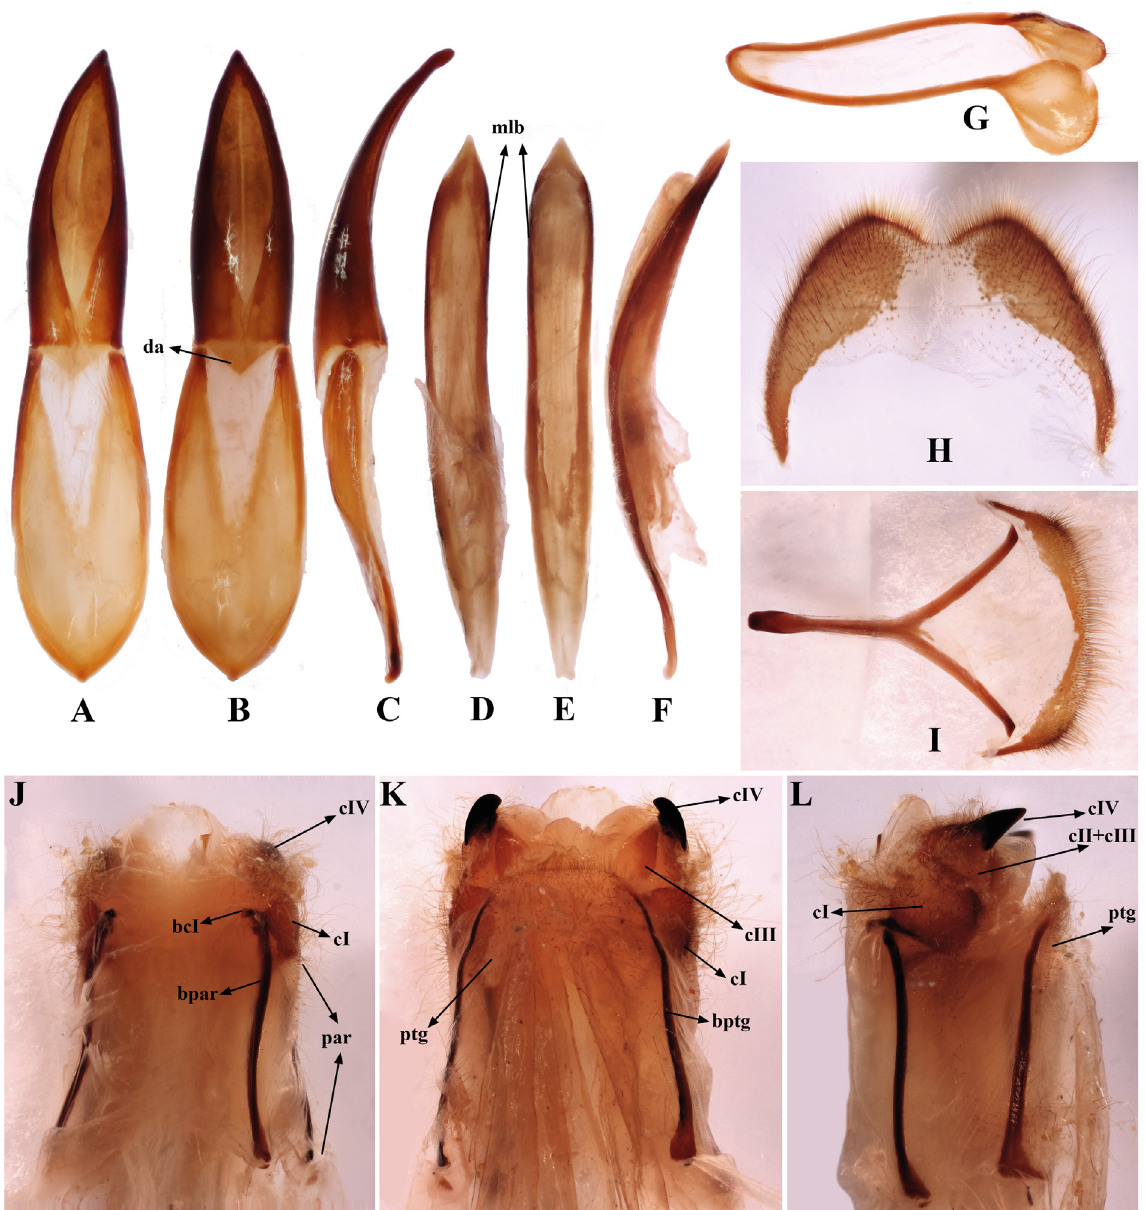
Fig. 19. Mantichorula semenowi Reitter, 1889 , genitalia (ZIN). A . Tegmen of aedeagus, ventrally. B . Ditto, dorsally. C . Ditto, laterally. D . Median lobe, ventrally. E . Ditto, dorsally. F . Ditto, laterally. G . Spiculum gastrale. H . ♂, inner sternite VIII. I . ♀, inner sternite VIII and spiculum ventrale. J . Ovipositor, ventrally. K . Ditto, dorsally. L . Ditto, laterally. Not to scale. Abbreviations: see Material and